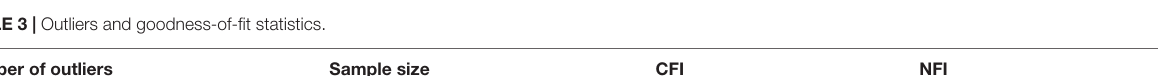
TABLE 3 | Outliers and goodness-of-fit statistics. Number of outliers Sample size CFI NFI GFI 60 2,056 0.97 0.97 0.97 Criterion for goodness of fit* ≥ 0.90 ≥ 0.90 ≥